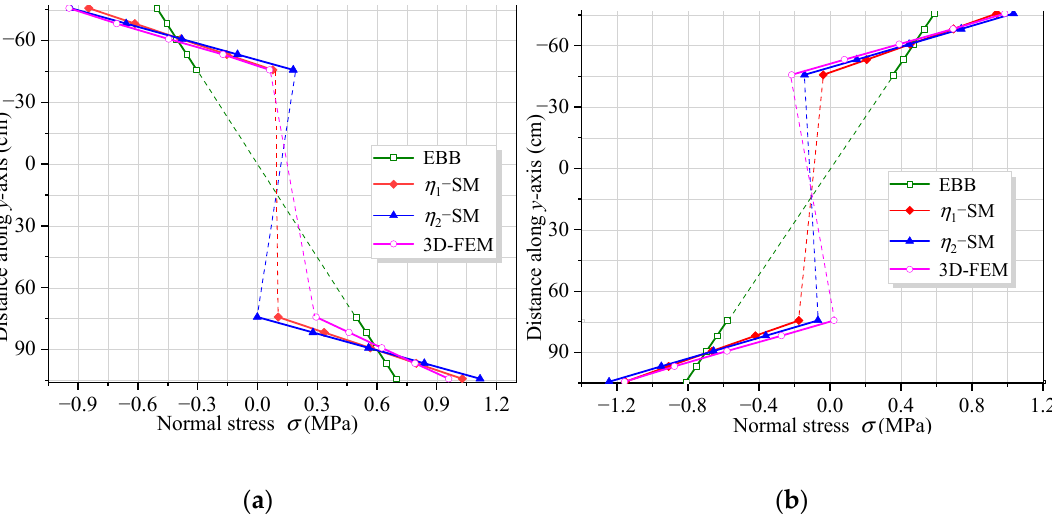
Figure 11. Vertical distribution of normal stress along the cross-section under load case 1: ( a ) cross-section 9.3 m away from the middle support; ( b ) cross-section 0.3 m away from the middle support.